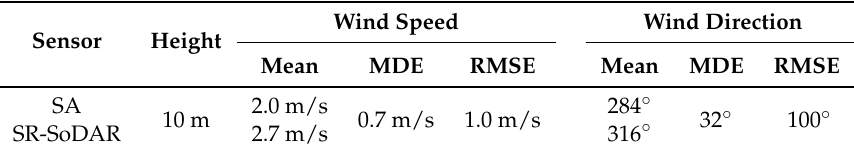
Table 8. Comparison of wind speed and wind direction observations collected from the sonic